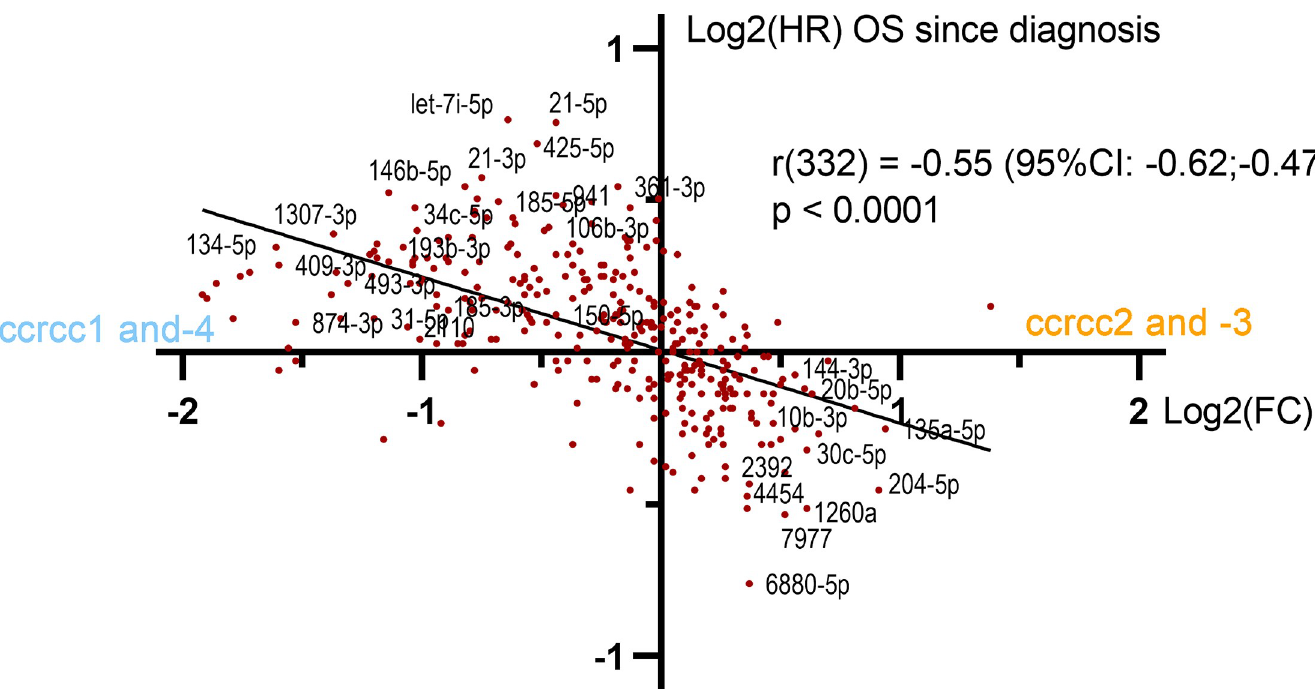
Fig 4. Scatterplot illustrating the correlation between subtype-specific miRNA expression (Log2(FC)) and HR for OS (Leuven dataset, n = 95). There was a strong correlation throughout the dataset, with a Pearson coefficient of -0.54 (332 degrees of freedom). Hazard ratio for OS is plotted on a log2-scale for graphical reasons; the regression line was fitted on the original data. HR = hazard ratio; OS = overall survival; FC = fold change.